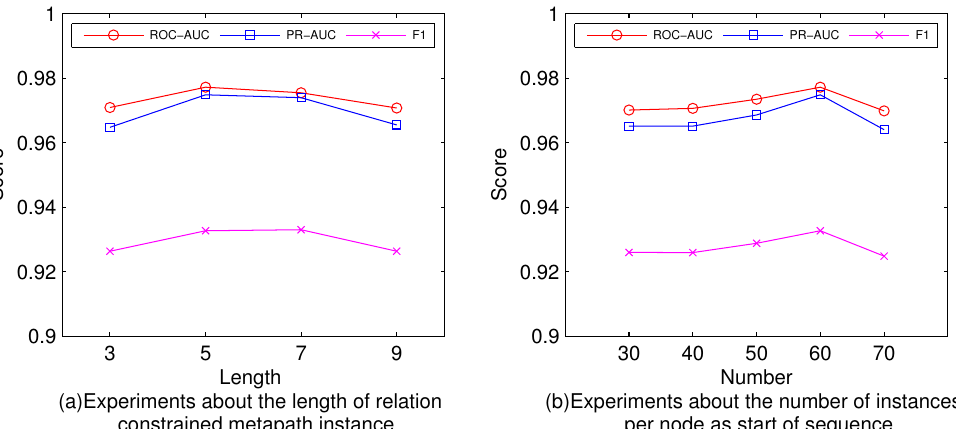
Figure 3. Parameters experiments of the Amazon